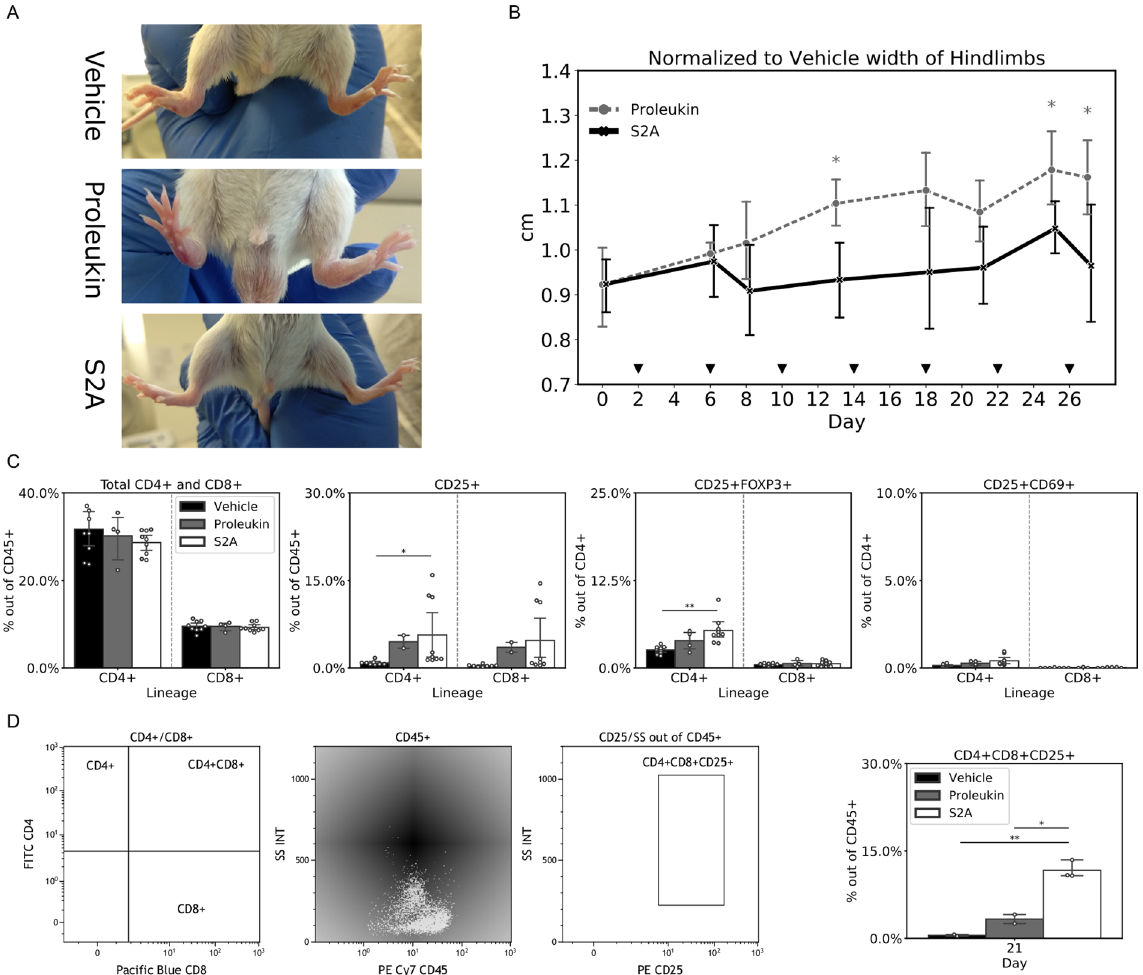
Figure 6. S2A’s effect on the development of rheumatoid arthritis (RA) in the IL-1ra KO model. IL-1ra KO mice spontaneously develop RA at the age of 3–6 weeks. Mice ((n = 8 in the S2A group, n = 4 in the Proleukin group and n = 9 in the vehicle group) were inoculated with 100,000 units every 4th days for a total of 7 inoculations. ( A ) Representative examples for the RA phenotype (inflamed and swollen hind-limb joints). ( B ) Joints width was measured, normalized to the vehicle, and plotted against time (black filled down pointing triangle indicates inoculations). Two-way ANOVA was performed on data, and while combined effect was not statistically significant, the treatment component was significant ( P < 0.0005). ( C ) At day 21, PBMCs were isolated. FACS analysis is arranged according to lineage and presented as a percentage of the population noted on the y-axis. ( D ) In addition to the normal phenotypes, this model presented a highly granulated double- positive (CD4 + CD8 +) phenotype, which also seemed to be almost entirely positive to CD25. Presented is a FACS gating scheme of this population ( E ) Representative plot of the double-positive phenotype induction in mice treated with Proleukin S2A and vehicle. Error bars represent 95% CI. *, P < 0.05; ** P < 0.005; ***, P <